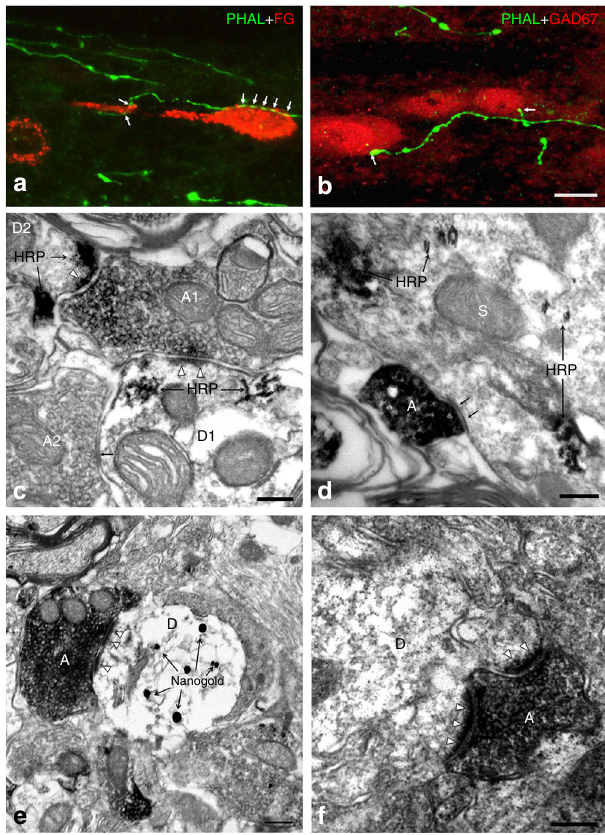
Fig. 9 ACC-spinal cord projecting fi bers and terminals connected with SDH neurons. a – b One Alexa-488-labeled PHA-L-IR fi ber (for PHA-L injected into the contralateral side of ACC) made close connection with one cy3 re- stained FG-labeled spinal lamina I neuron (for FG injection into the contralateral PBN) ( a ) or two cy3-labeled GAD67-IR neurons in spinal lamina II ( b ). c One DAB stained PHA-L containing axon (A1) made asymmetric synapses with two HRP-labeled dendritic spines (D1, 2), noting that the axon terminal mainly contained round and clear vesicles. An immunonegative axon (A2) also made symmetric synapse with D1, noting the axon terminal mainly contained fl at and clear vesicles. d One PHA-L containing axon made symmetric synapse with one HRP-labeled soma (S). e – f One PHA-L containing axon made asymmetric synapses with one nanogold-labeled GAD67-IR ( e ) or immunonegative dendritic spine ( f ). Arrows in a – b indicate the close connection sites, in c – d indicate the symmetric synapses. Triangles point to the asymmetric synaptic